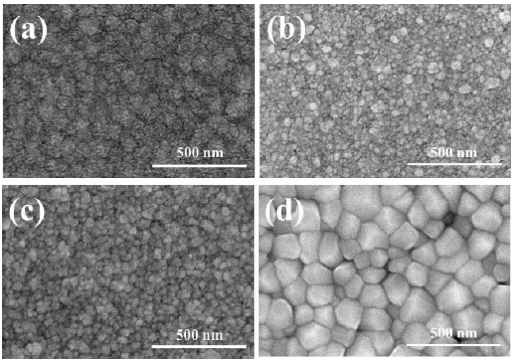
Figure 2. SEM images of the WO 3 thin films with and without annealing: ( a ) as-grown, ( b ) 400 °C, ( c ) 500 °C, ( d ) 600 °C.